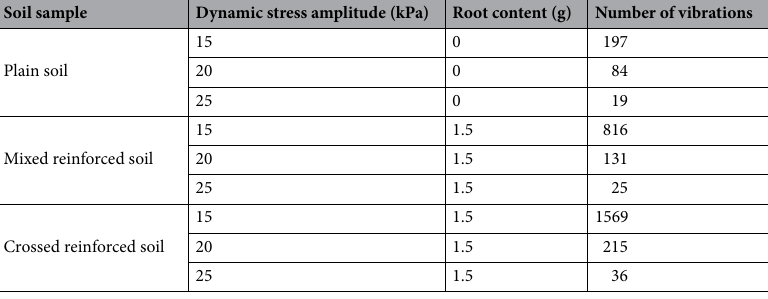
Table 2. Dynamic triaxial test